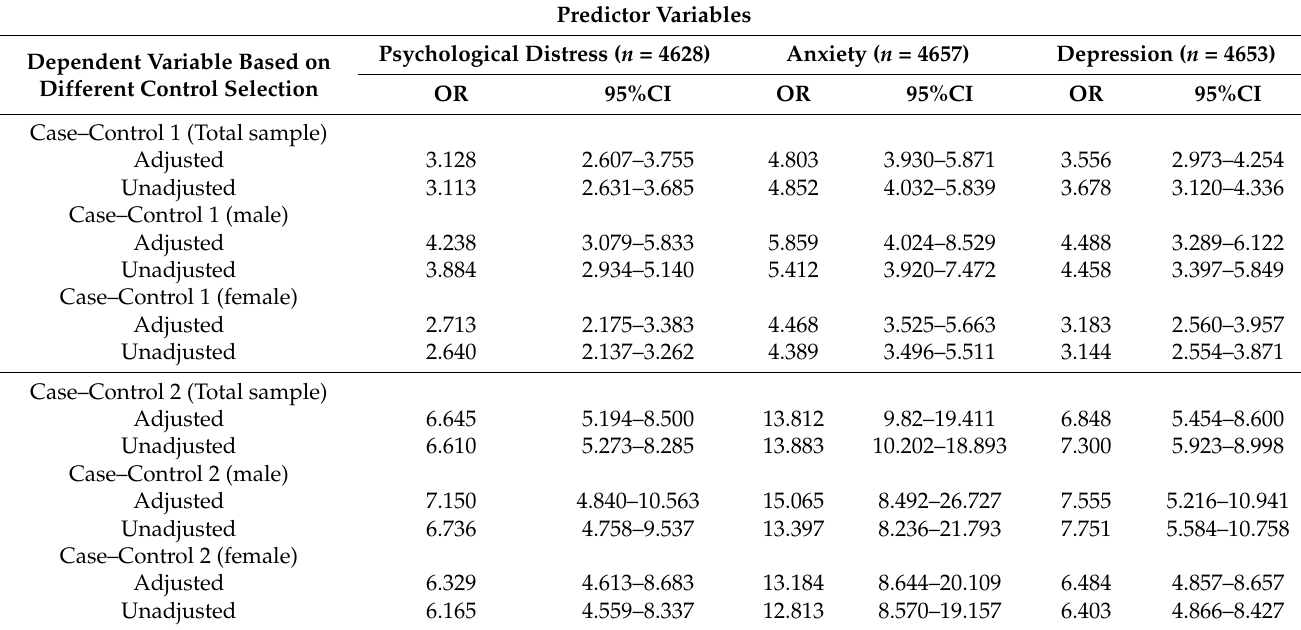
Table 3. OR and 95% CI for the association of functional dyspepsia and psychological disorders. Predictor